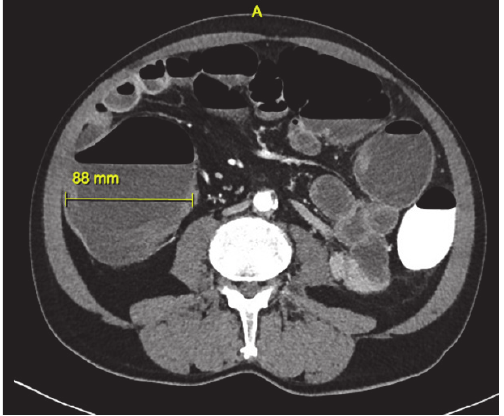
Figure 2: Abdominal CT scan of the abdomen after 300 mL rectal gastrografin and 100 mL intravenous nonionized iodine contrast. Status after partial sigmoidectomy. Gross colonic distension (Ø 88 mm), especially marked at the splenic flexure, without patholog- ical bowel wall thickening. Distension of the terminal ileum, with signs of wall thickening. No free air or fluid, no suture leakage, no abscess, and no signs of